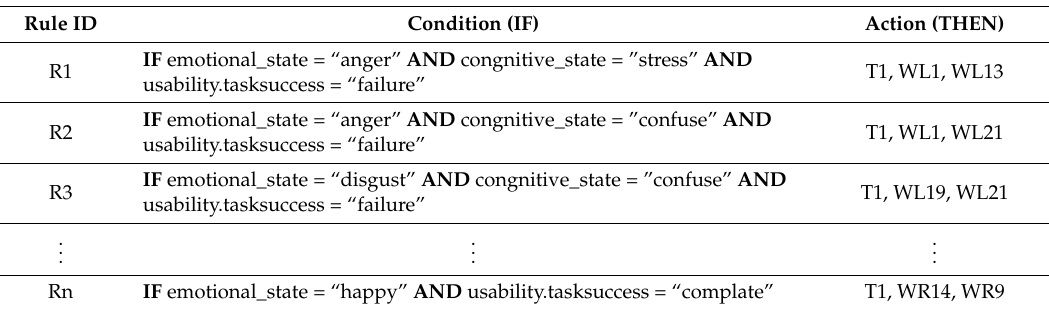
Table 1. A partial list of candidate rules.